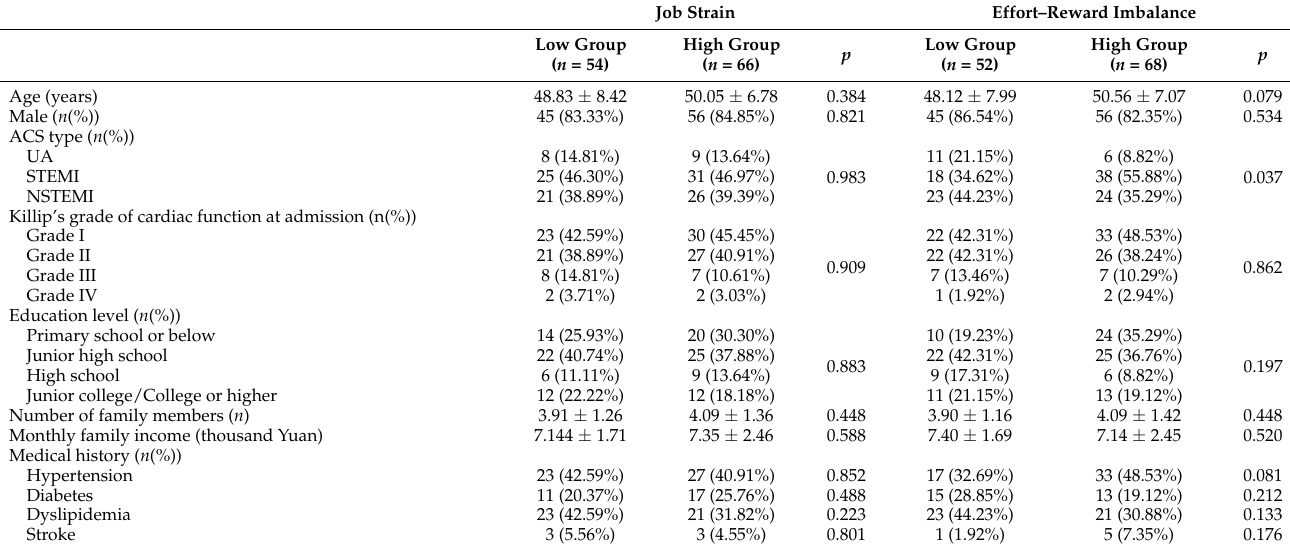
Table 1. Characteristics of subjects at the baseline ( n =